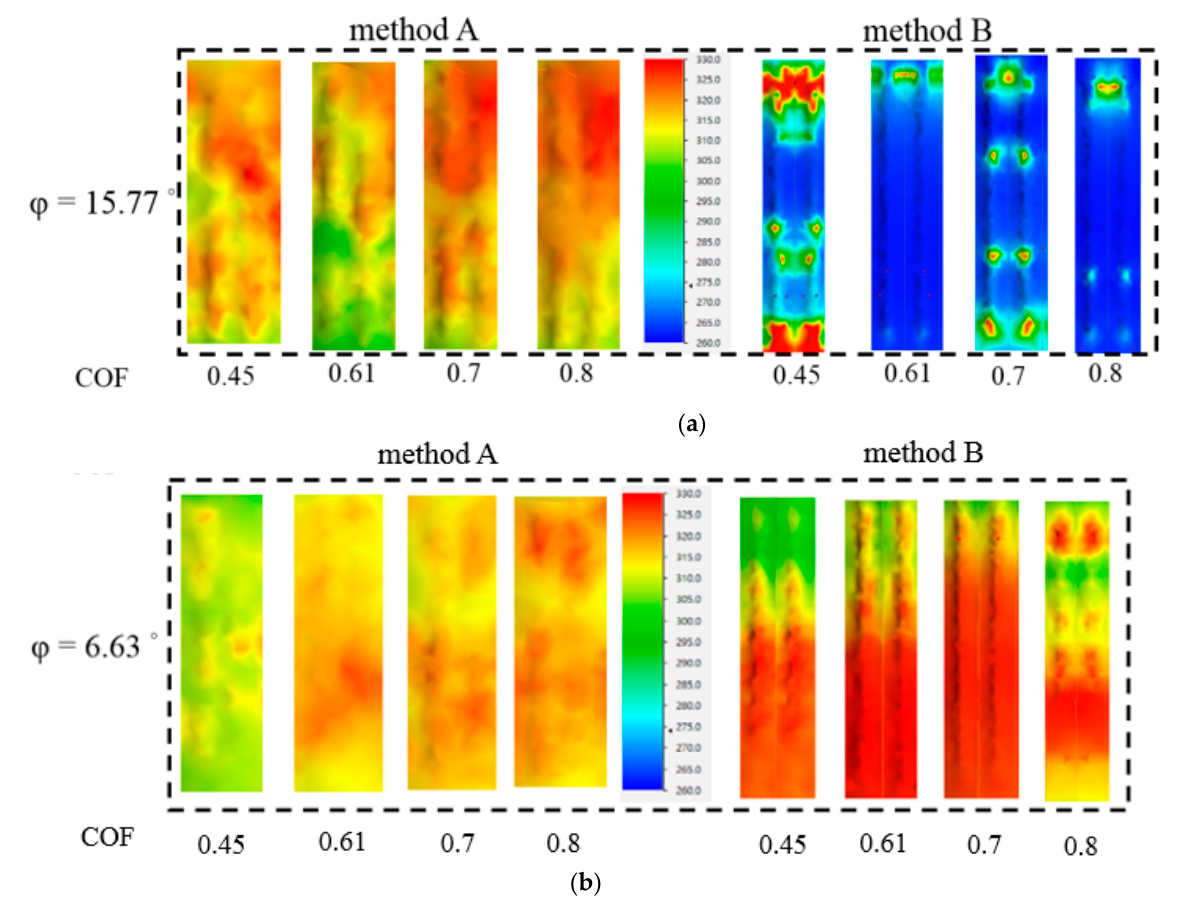
Figure 13. Effective stress at the groove of the hub surface with different COF values: ( a ) shaft angle of 15.77° and ( b ) shaft angle of 6.63°.